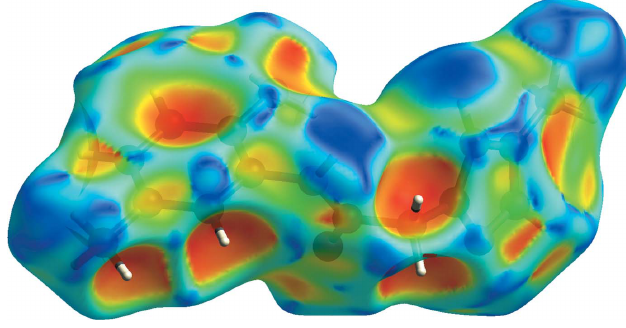
Figure 5 Hirshfeld surface of the title compound plotted over shape-index.